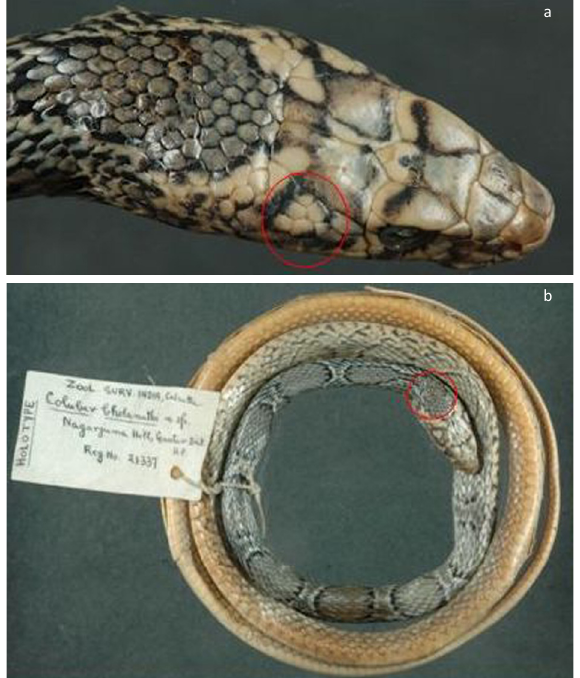
Image 5. Dorsal pattern of head (a) and body (b) of holotype of Coluber bholanathi , ZSIC 21337. Notice the presence of light coloration in the temporal area (a) and the round nuchal blotch (b) (highlighted by